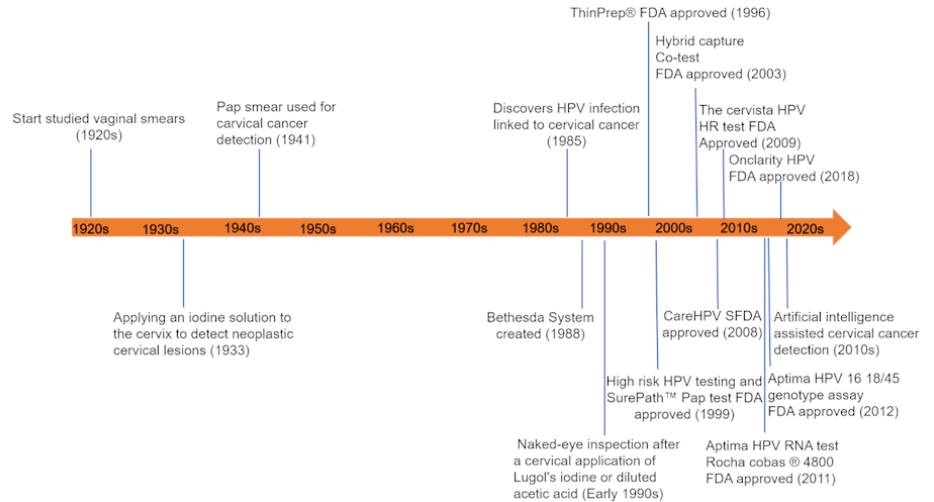
Figure 1. The schematic summarizes the timeline of the development of cervical cancer detection. The study of vaginal smears began in the 1920s, followed by the cytologic identification of neoplastic lesions using iodine solution (1930s) and the Papanicolaou stain (1941). After the discovery of the causal link between HPV infection and cervical cancer in 1985, HPV nucleic acid tests were included as a standard diagnostic test in the laboratory. In recent years, the artificial intelligence (AI)-assisted detection platform has become popular [21,22,23–33].